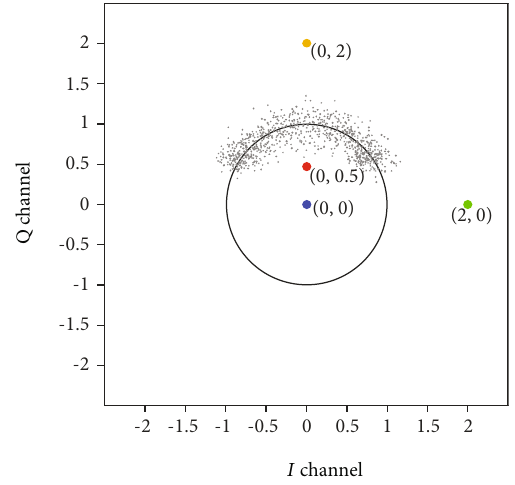
Figure 5: The constellation of simulated signal and four points for demodulation as DC o ff set: DC o ff set 1 (0, 0); DC o ff set 2 (0, 0.5); DC o ff set 3 (0, 2); and DC o ff set 4 (2,